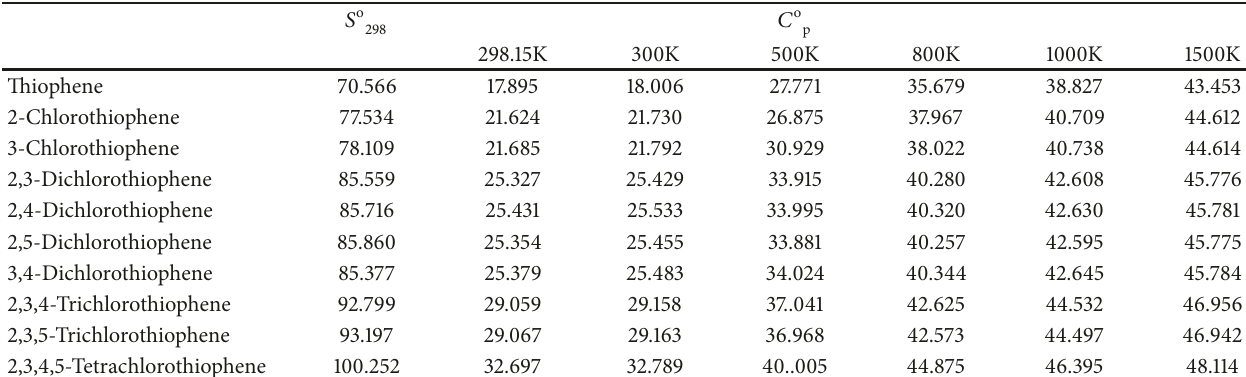
Figure 2: Chlorination sequence of thiophene predicted based on Fukui indices of electrophilic attack, f −1 (r). Table 1: Values of standard entropy ( 𝑆 o ) and heat capacity at constant pressure ( 𝐶 o p ) at selected temperatures for chlorinated thiophene isomers. 𝑆 o 298 in cal/(mol K) and C o p (T) in cal/(mol K).